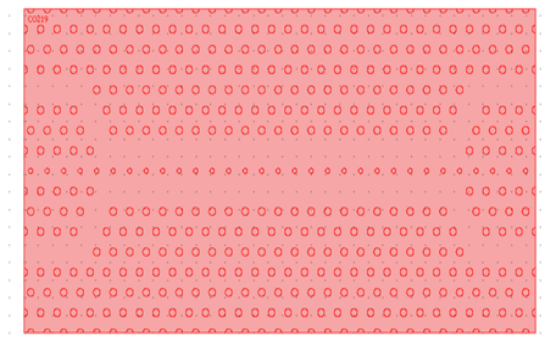
Figure 3 :Periodic structures of Photonic crystal without